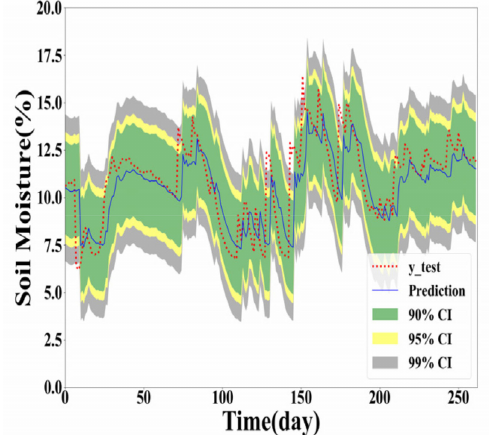
Figure 10. GPR model built with the chosen data in Y(3) prediction.